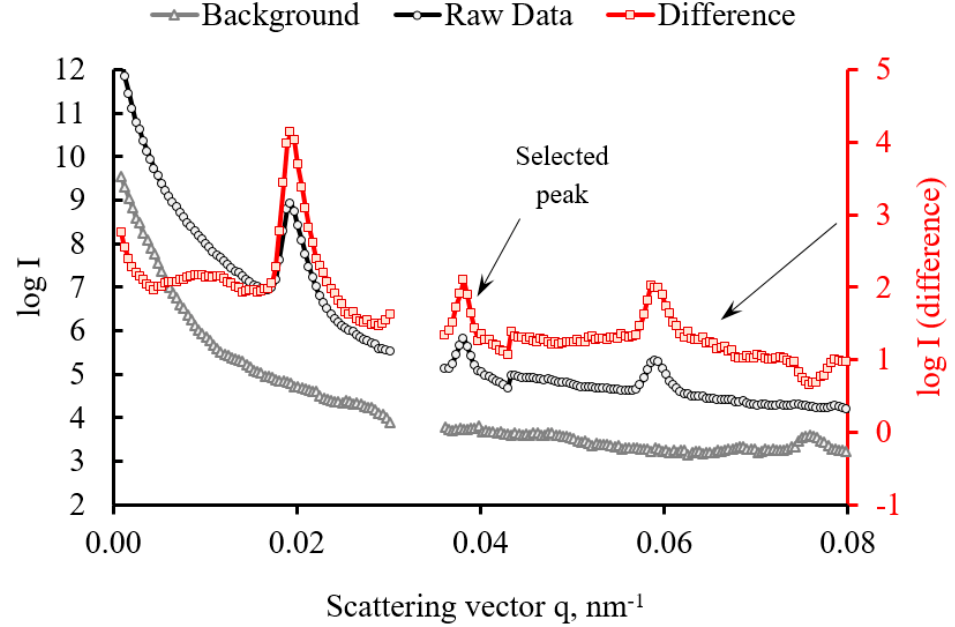
Figure 10. Raw SAXS profile (circle markers), background curve (triangle markers) and difference curve (square markers; red curve referred to the right hand scale).